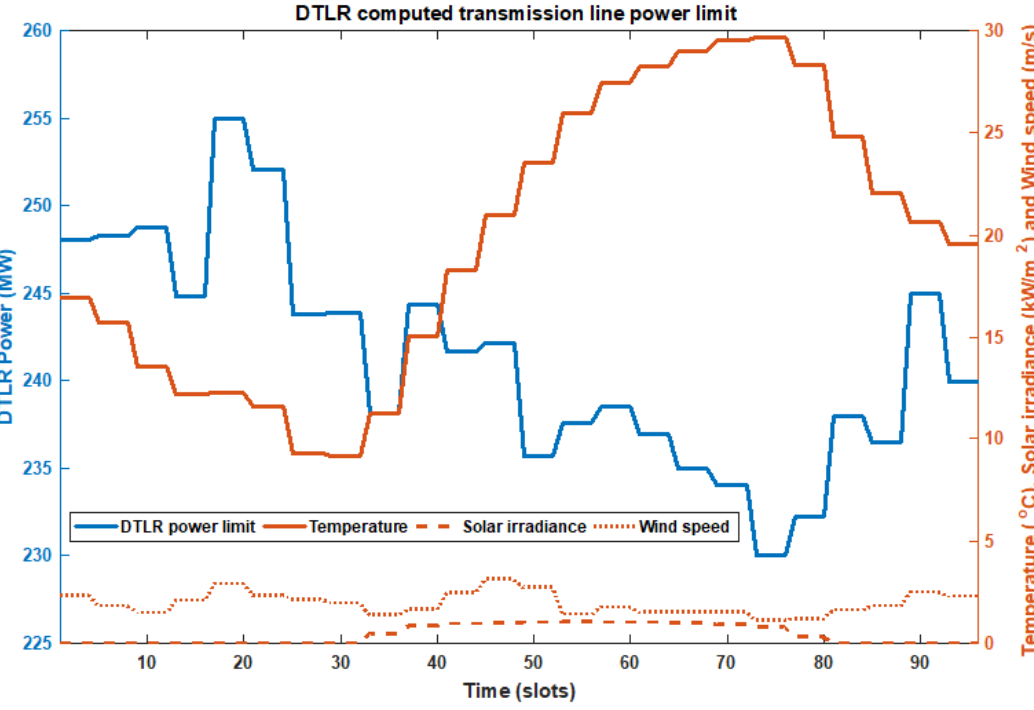
Figure 8. Dynamic thermal line power rating variation based on varying weather conditions.